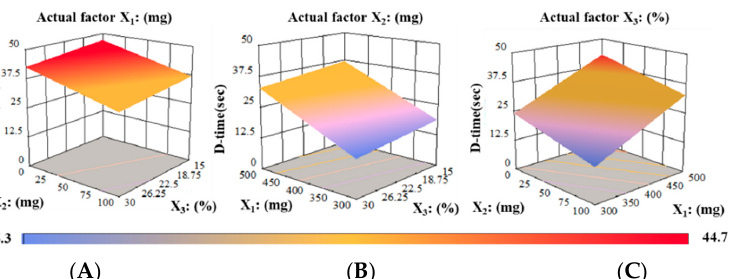
Figure 11. 3D surface models describing the influence of ( A ) PUL (X 1 ), ( B ) MTX (X 2 ), and ( C ) PG (X 3 ) on D-time (Y 7 ) of RZT-ODFs.